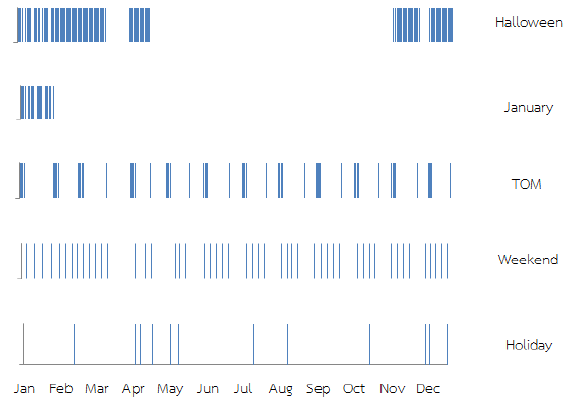
Fig. 1. Five calendar effects in a